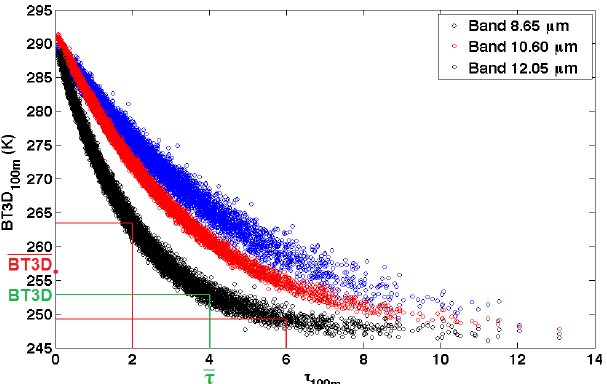
Figure 7. Variation of the 3-D brightness temperatures BT 3 D 100m as a function of the optical thickness at 100m × 100m τ 100m for the three IIR channels and for cirrus 5. BT3D represents the aver- age of BT3D 100m , corresponding to two τ 100m , BT3D represents the 3-D brightness temperature corresponding to the mean optical thickness ¯ τ . The mathematical formulation of the PPA due to the Jensen inequality is expressed by BT3D > BT3D ( ¯ τ)